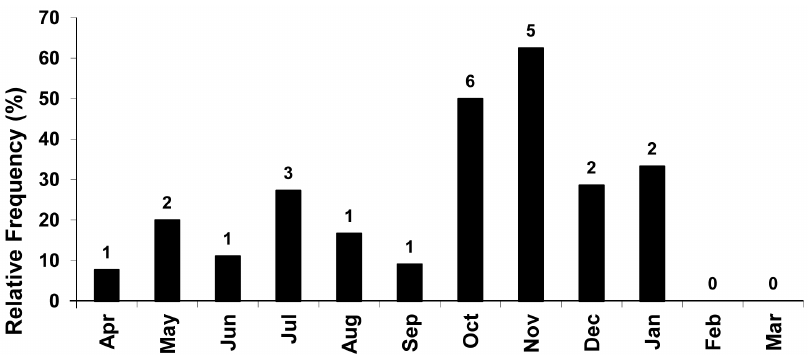
Figure 6. Hypertrophy of male caudal filament. Monthly variation of the relative frequency of males of Brachyhypopomus gauderio with hypertrophy of the distal portion of caudal filament. Numbers above the columns correspond to the absolute values.